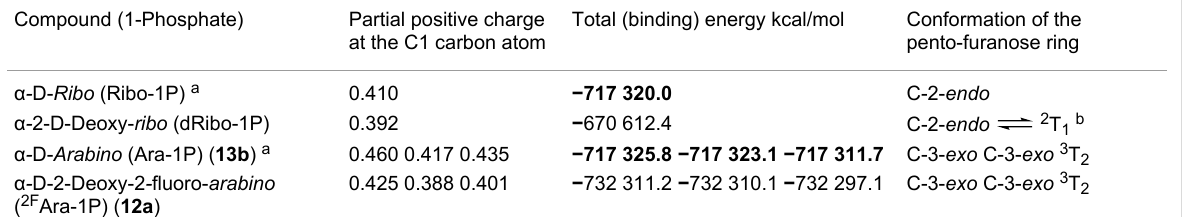
Table 3: Geometry optimization of 2-deoxy-2-fluoro- α -D-arabinofuranose-1-phosphates ( 12 a) vs α -D-arabinofuranose-1-phosphate, α -D-ribofuranose- 1-phosphate, and 2-deoxy- α -D-ribofuranose-1-phosphate [dilithium salts; HyperChem 8.1; AMBER Force Field starting approximation then the ab initio calculations ( in vacuo , basis set; 3-21G; total charge equal to zero; Polak-Ribiere conjugate gradient)]. Compound